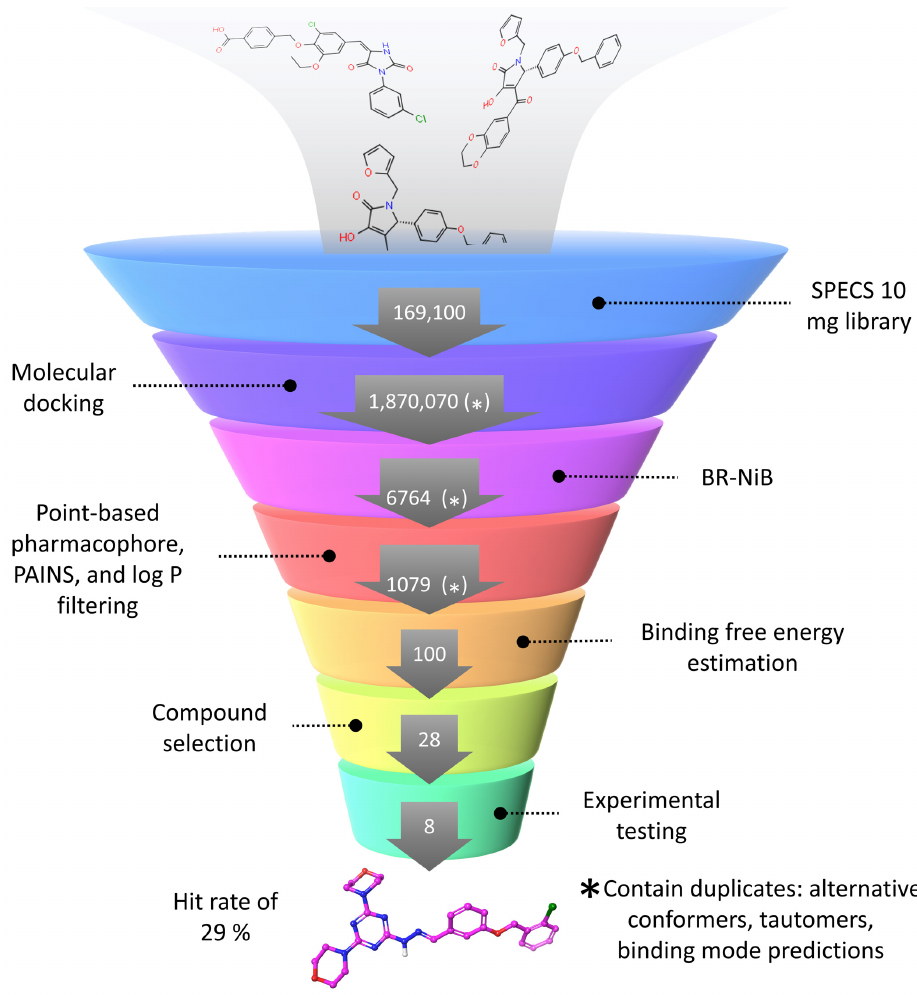
Figure 5. The docking and shape-focused filtering protocol used in virtual screening. (1) The SPECS 10 mg compound library set, which is composed of one hundred sixty-nine thousand and one hundred compounds, was flexibly docked and generated one million eight hundred seventy thousand and seventy entries for both protein structures. This number includes alternative tautomers, enantiomers, and ten docking poses for each compound referred here as duplicates ( * ). (2) After BR-NiB processing, one thousand six hundred and ninety-one top-ranked SPECS compounds were extracted for each optimized model (4 × 1691), yielding six thousand seven hundred and sixty-four entries. This number again includes duplicates. (3) Point-based pharmacophore and PAINS filtering was performed for the remaining compounds and, furthermore, logP filtering was done for the remaining compounds, yielding one thousand and seventy-nine entries with duplicates. (4) Next, one hundred top-ranked compounds were obtained based on the binding free energy calculations for all remaining compounds. (5) Twenty-eight compounds were selected for purchase after visual inspection. (6) Eight of the in vitro tested compounds were determined active at the low-micromolar range, yielding a hit rate of